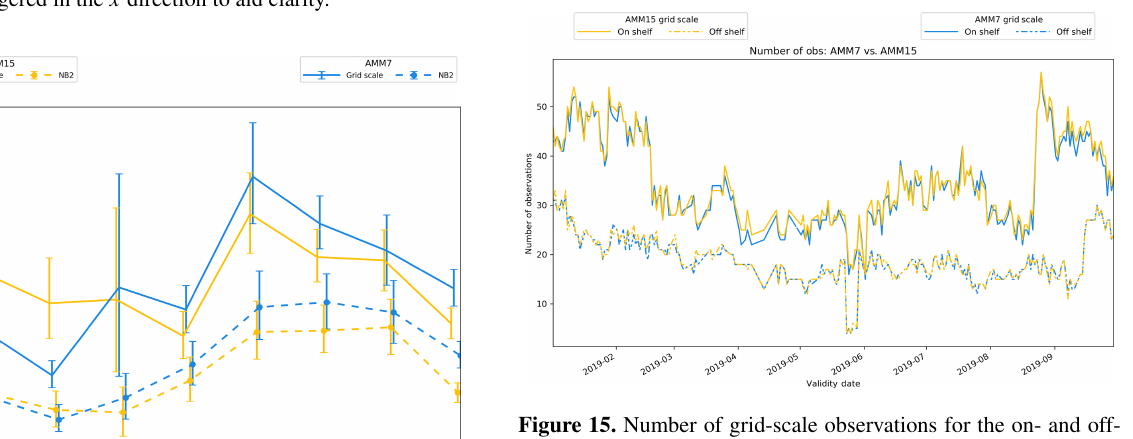
Figure 15. Number of grid-scale observations for the on- and off- shelf